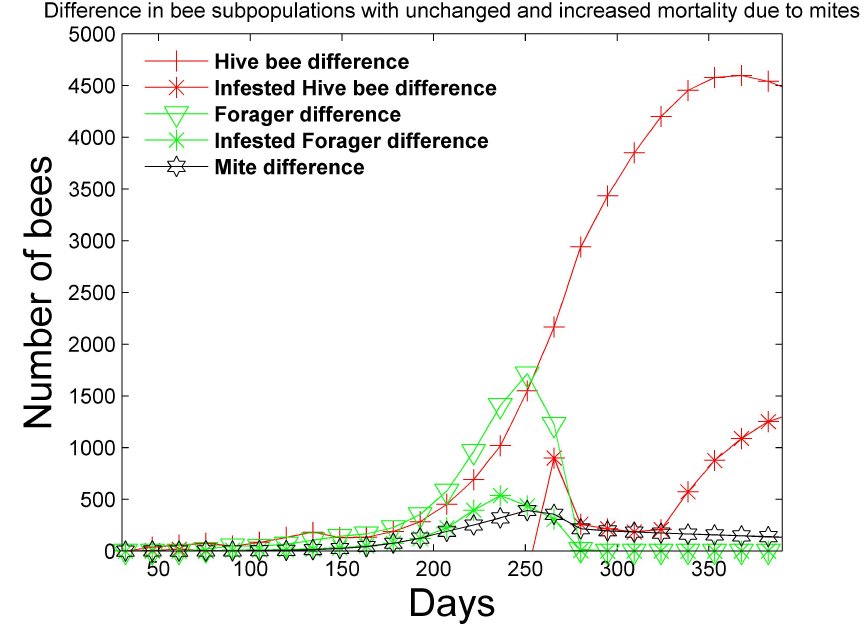
Figure 7. Two-year simulation of a honey bee colony with mites using the simulation parameters in Tables 4 and 5. Mites increase the mortality rates in Table 3 of infested pupae, hive, drone, and foragers by four times. Only the first year is shown since the colony does not survive past the first year. In this figure, the difference between the number of bee subpopulations (total hive bees, infested hive bees, total foraging bees, and infested foraging bees) with unchanged mortality (Figures 1 and 2) and the bee subpopulations with increased mortality is plotted.